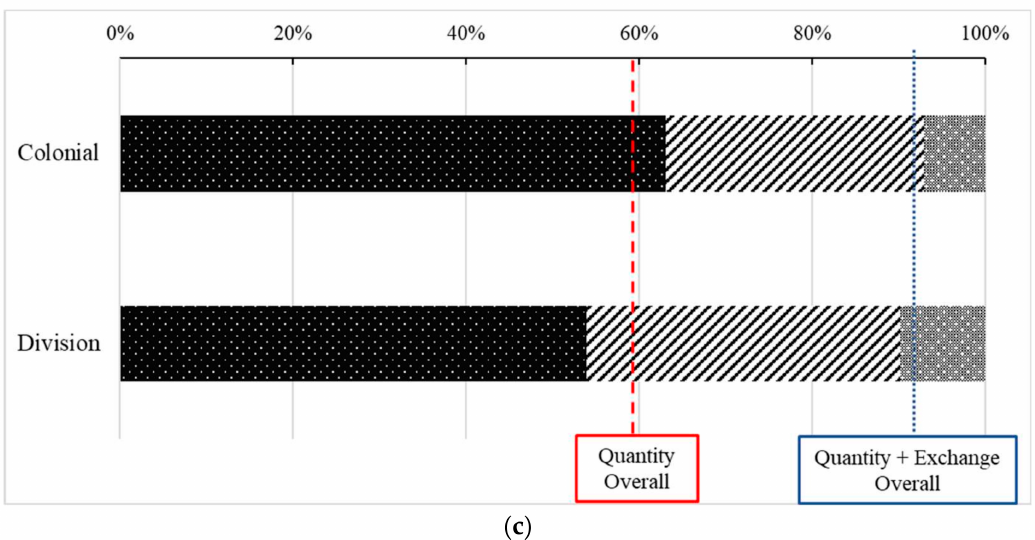
Figure 7. Interval level change (divided into Quantity, Exchange, and Shift) with respect to: ( a ) area, ( b ) intensity, and ( c )